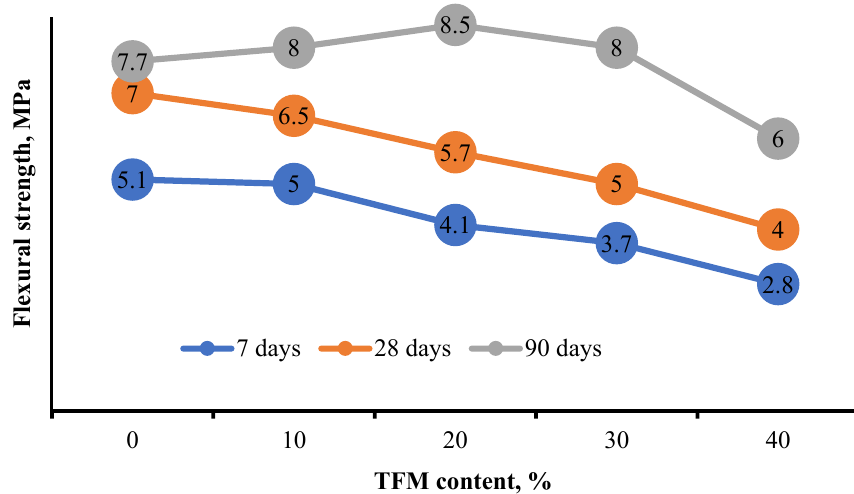
Figure 9. Dependence of concrete flexural strength on the consumption of additive TFM.